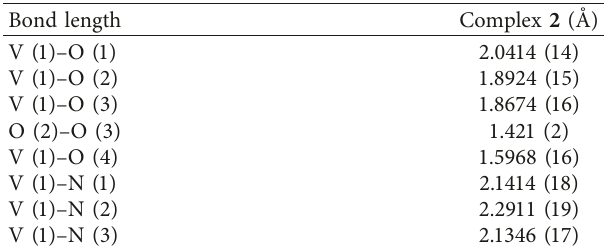
Table 2: Bond distances of complex 2 .